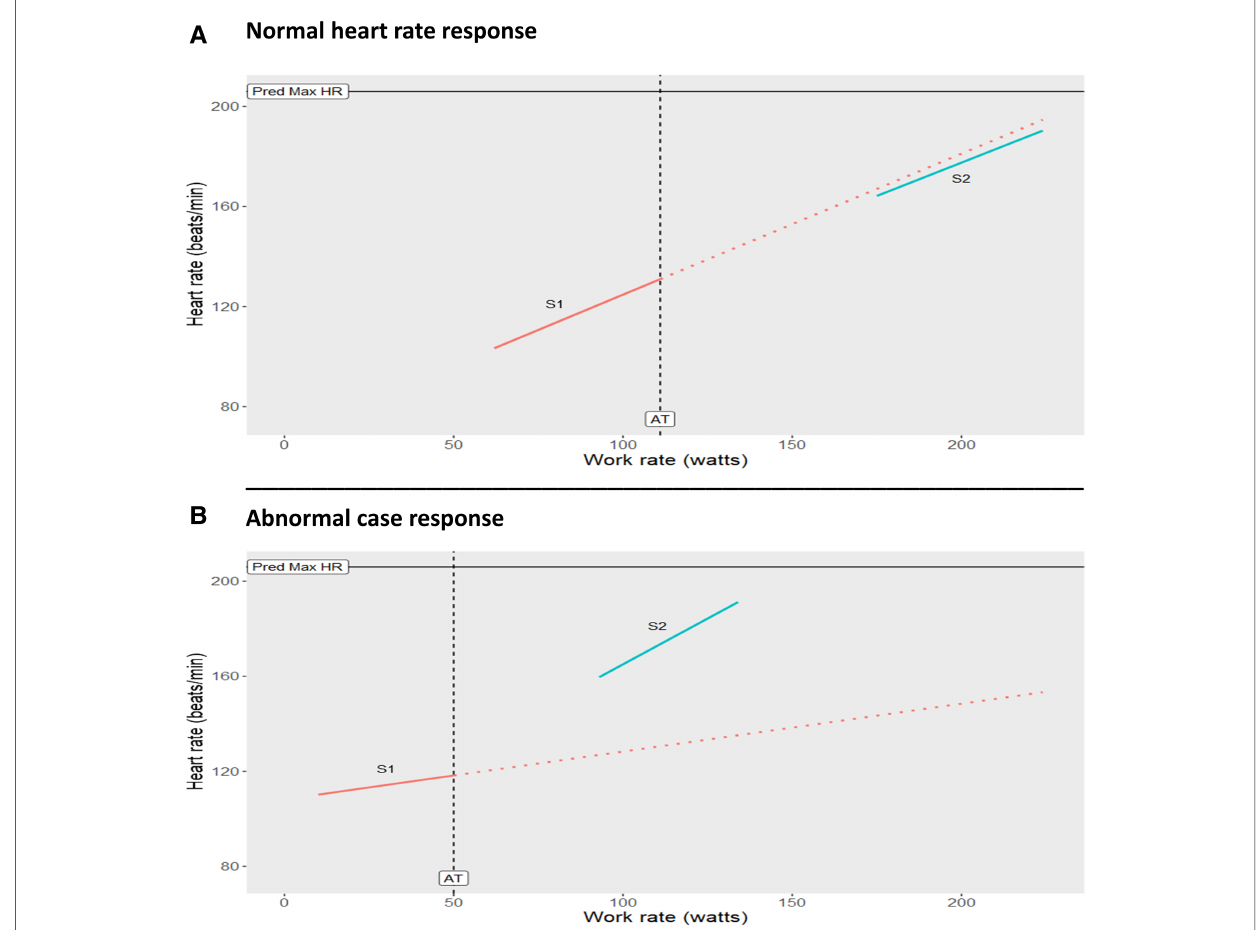
FIGURE 2 ( A) : Normal heart rate response seen in a healthy 14-year old male control showing normal cardiac function. Note there is only a slight change in slope ( − 5%) between the 2 min prior to exercise test termination (S2) and the 2 min prior to AT (S1). ( B ): Abnormal heart rate response from the case participant 14-year old male showing cardiac dysfunction. Note the signi fi cant steepening of slope S2 (286%) in late exercise compared to the baseline S1. S1=slope of line of best fi t for heart rate response in the 2 min prior to the exercise test termination. Dashed lines represent trajectory of S1 (baseline slope). AT, anaerobic threshold; Pred Max HR, predicted maximum heart